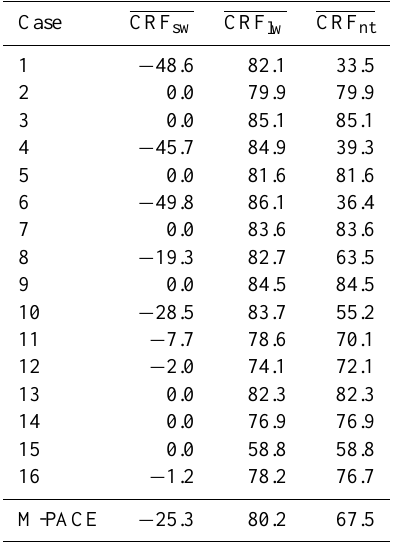
wave cloud radiative forcing does not include nighttime